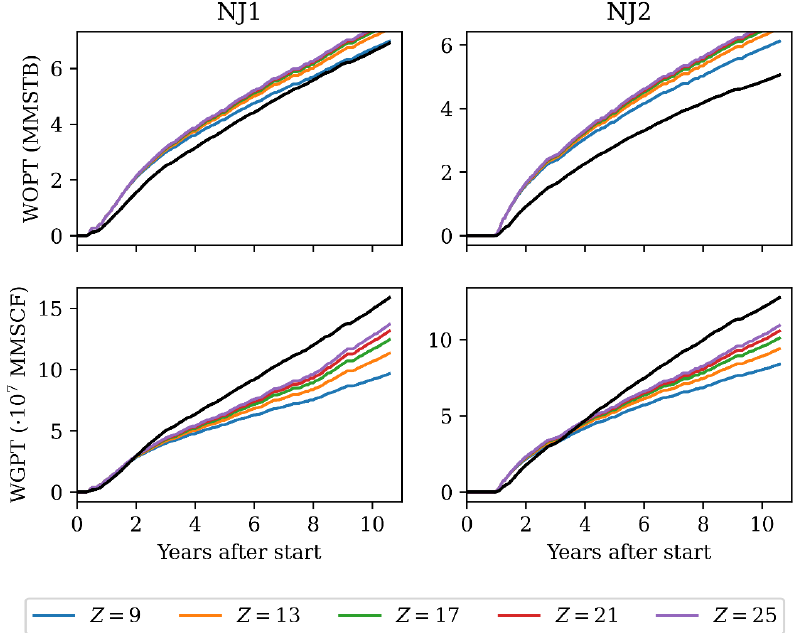
Figure 11. The production volumes for the North Jens model, corresponding to the different relative permeabilities in Figure 10. Black lines denote historical data.